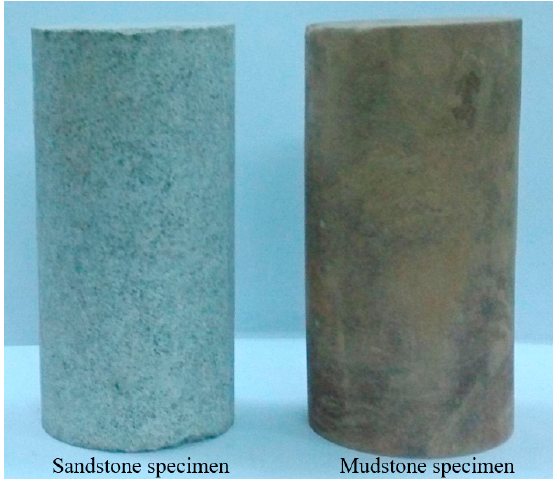
Figure 1. Typical sandstone and mudstone specimens.